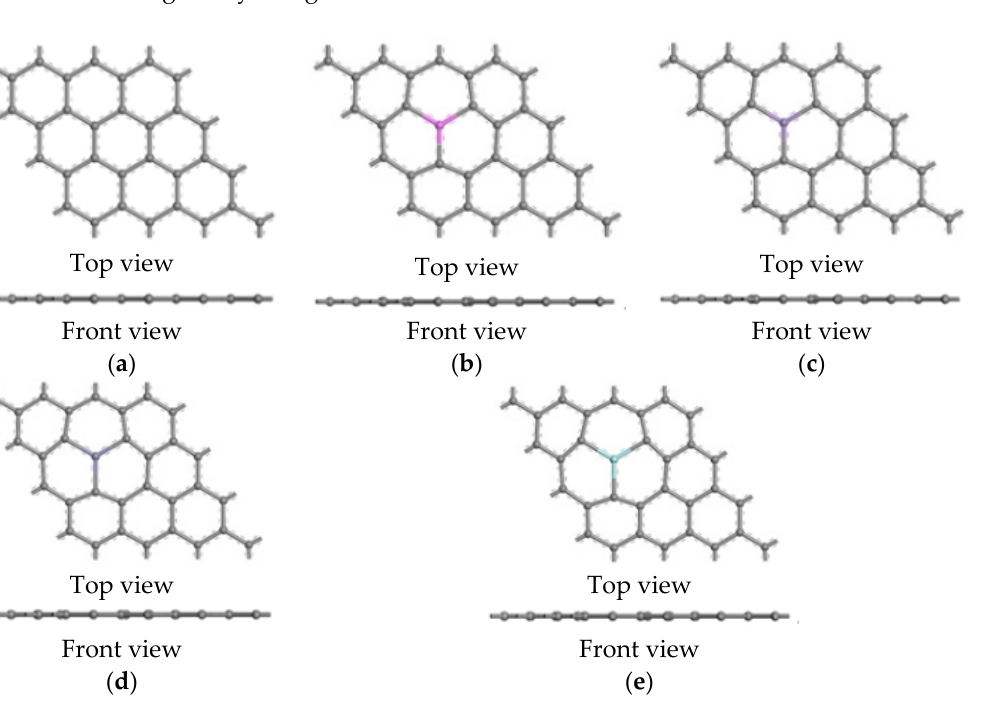
Figure 2. Ball and stick model of the intrinsic and doped graphene following the DFT calculation. ( a ) Intrinsic graphene sheet, ( b ) Al-doped graphene sheet, ( c ) Mn-doped graphene sheet, ( d ) Zn-doped graphene sheet, ( e ) Zr-doped graphene sheet. Table 1. Energies of the intrinsic graphene and doped graphene (Al, Mn, Zn, and Zr) following the DFT calculation (unit: eV).